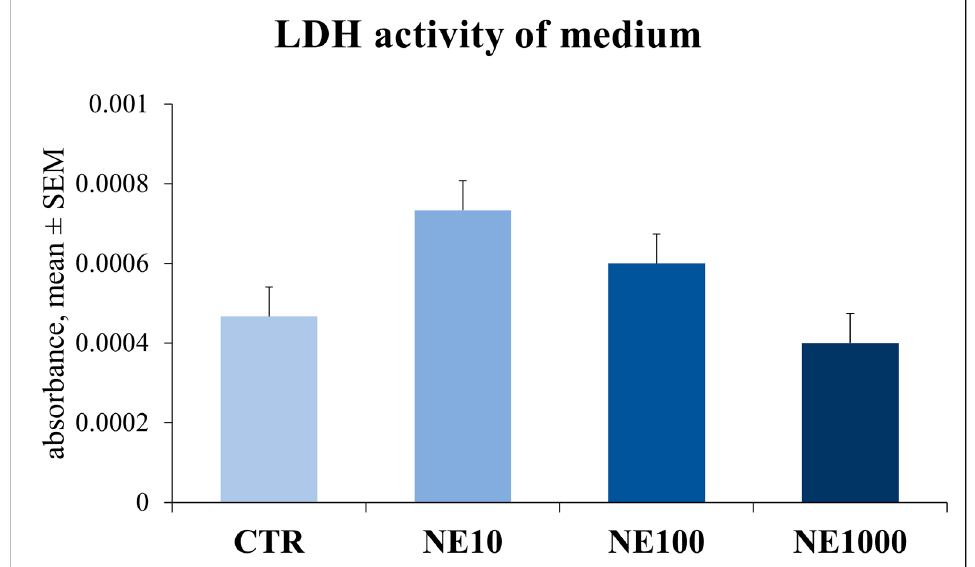
Figure 6. Lactate dehydrogenase (LDH) activity in cell culture media after 1-h norepinephrine treat- ment. CTR = non-treated control cells, NE10 = 10 µM norepinephrine treated cells, NE100 = 100 µM norepinephrine treated cells, NE1000 = 1000 µmol/L norepinephrine treated cells. n = 6/group, re- sults are expressed as mean ± SEM.